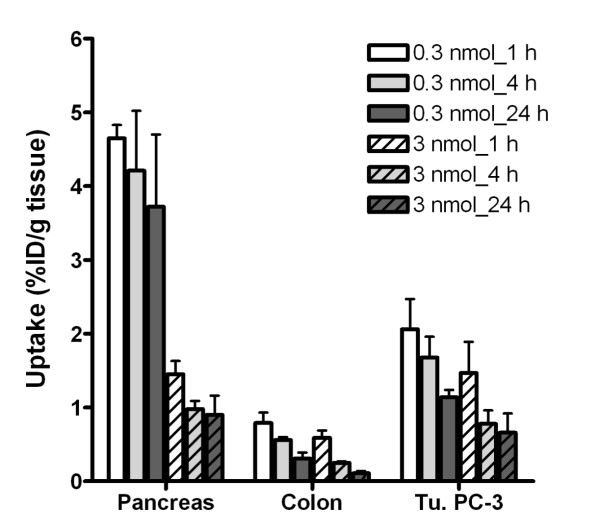
Influence of the amount of injected peptide on the biodistribution of177Lu-DOTA-PEG5k-Lys-BN.